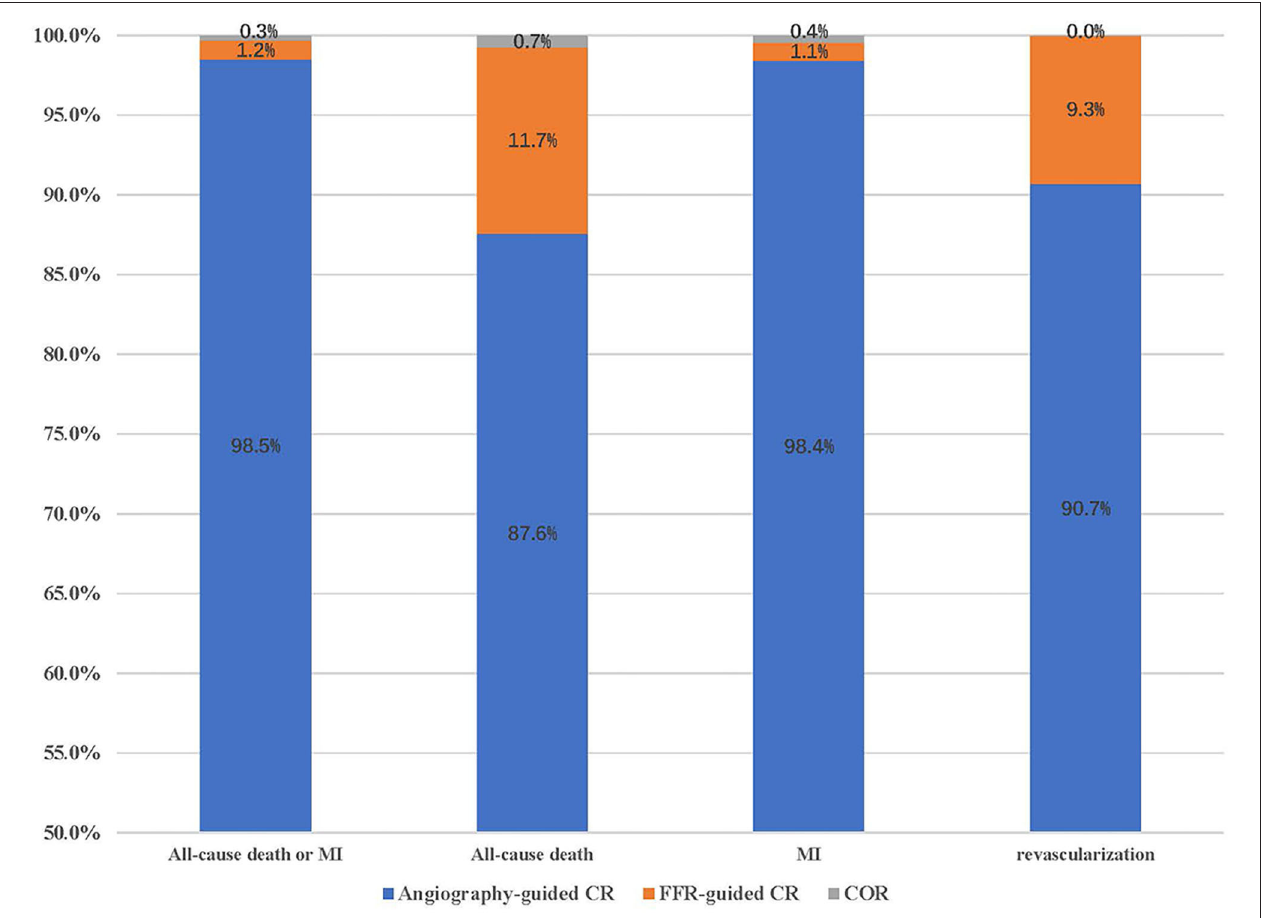
FIGURE 3 | The probability of being the first treatment option for the clinical outcomes. MI, myocardial infarction; COR, culprit-only